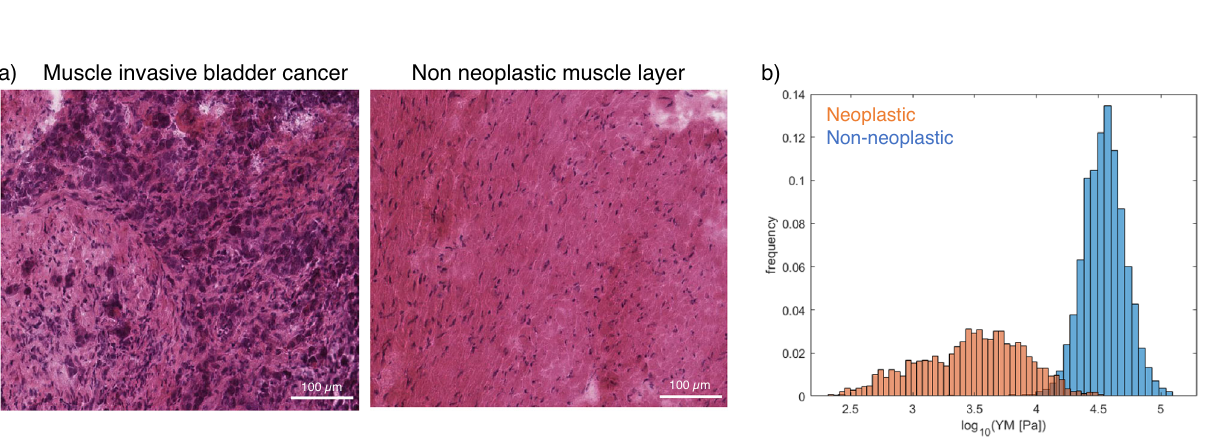
Fig. 5 Micromechanics of high grade human bladder cancer. a Hematoxylin-eosin staining of muscle invasive bladder cancer and paired non-neoplastic muscle tissue from a patient with high-grade urothelial carcinoma. b Mechanical pro fi le of neoplastic (orange) and non-neoplastic (blue) muscle tissue from the same patient ( n = 1). Data collected with the nanoindenter. Data are shown as logarithm in base 10 of YM ’ s (in Pa). Source data behind graphs and charts can be found in https:// fi gshare.com/projects/Micro-mechanical_ fi ngerprints_of_the_rat_bladder_change_in_actinic_cystitis_and_tumor_